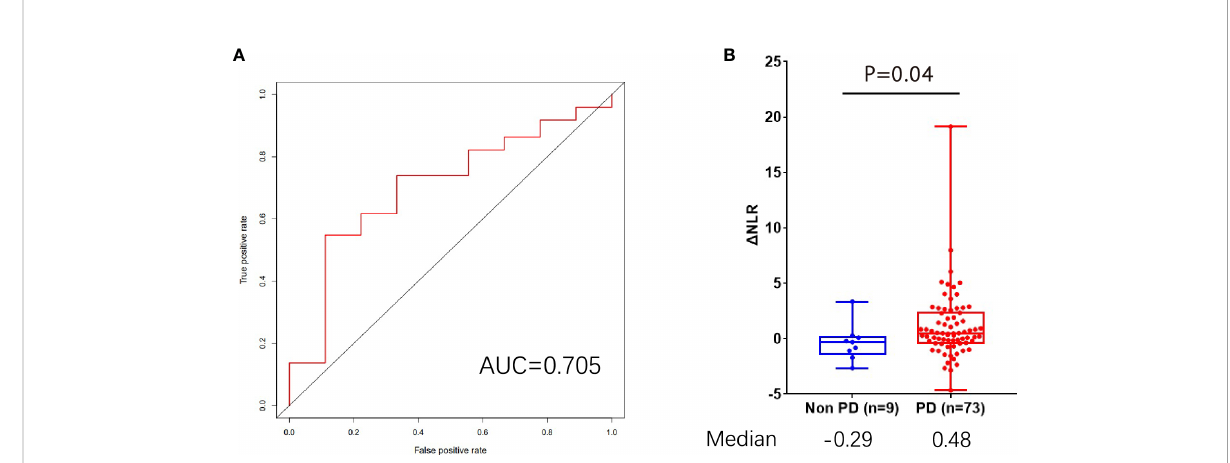
FIGURE 4 The predictive role of △ NLR for progressive disease. (A) AUC analysis of the △ NLR. (B) Distribution of △ NLR value in PD and non-PD groups. PD, progressive disease; AUC, areas under the receiver operating characteristic curve; NLR, neutrophil-to-lymphocyte